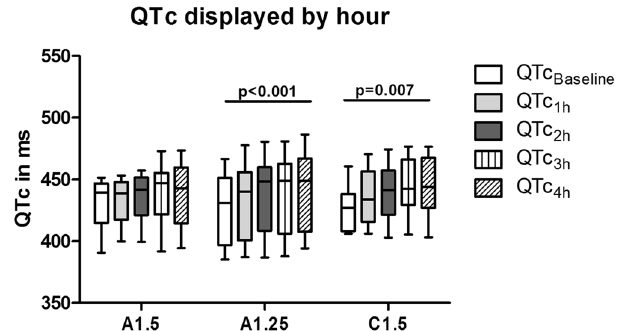
Figure 1. QTc displayed per hour : Data are expressed as median with minimum and maximum. A1.5 = acetic- acid dialysate with calcium concentration 1.50 mmol/l. A1.25 = acetic-acid dialysate with calcium concentration 1.50 mmol/l. C1.5 = citric-acid dialysate with calcium concentration 1.50 mmol/l. QTc Baseline = QTc of the first median complex (first 2 min of haemodialysis). QTc 1h , QTc 2h , QTc 3h , QTc 4h = median QTc of respectively the first, second, third and fourth hour of haemodialysis. *p-value was measured with Friedman’s